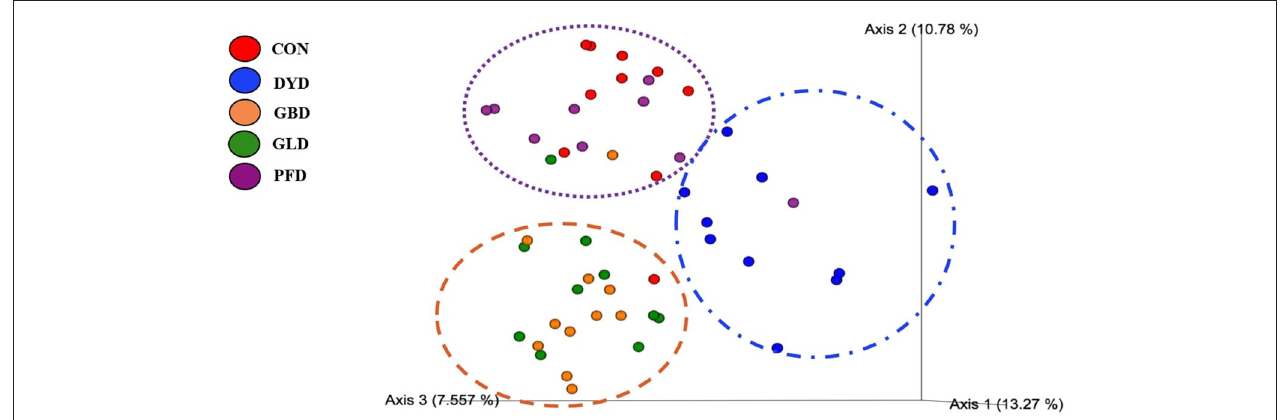
Dietary treatment 1